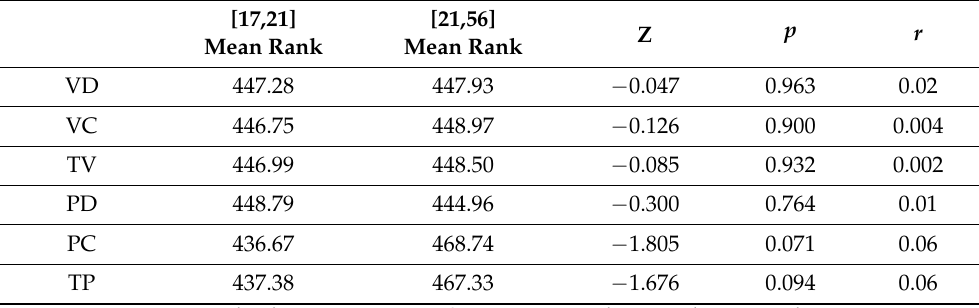
Table 3. Comparative analysis of victimization and perpetration by age.